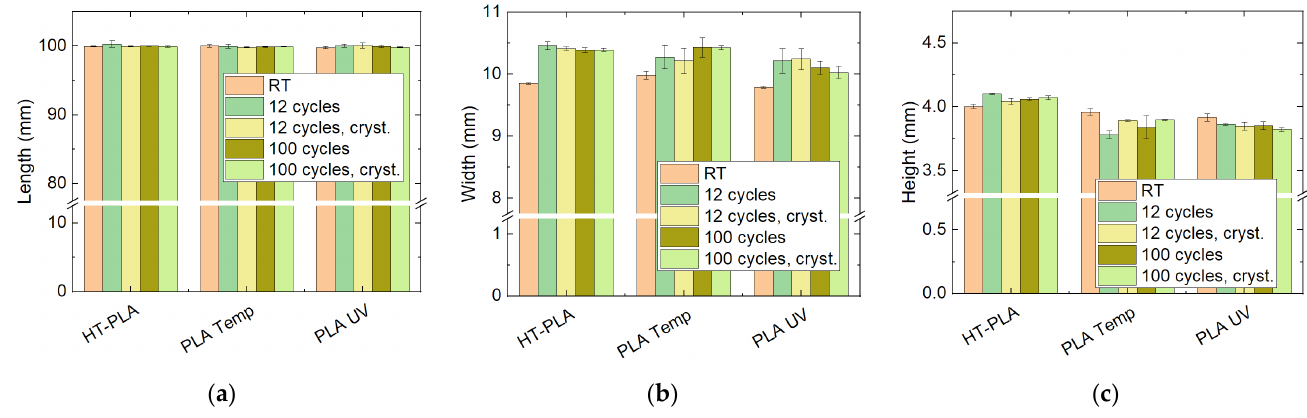
Figure 15. Dimensions of chosen PLA materials after cyclic thermal tests in the climate chamber: ( a ) length; ( b ) width; ( c ) height.